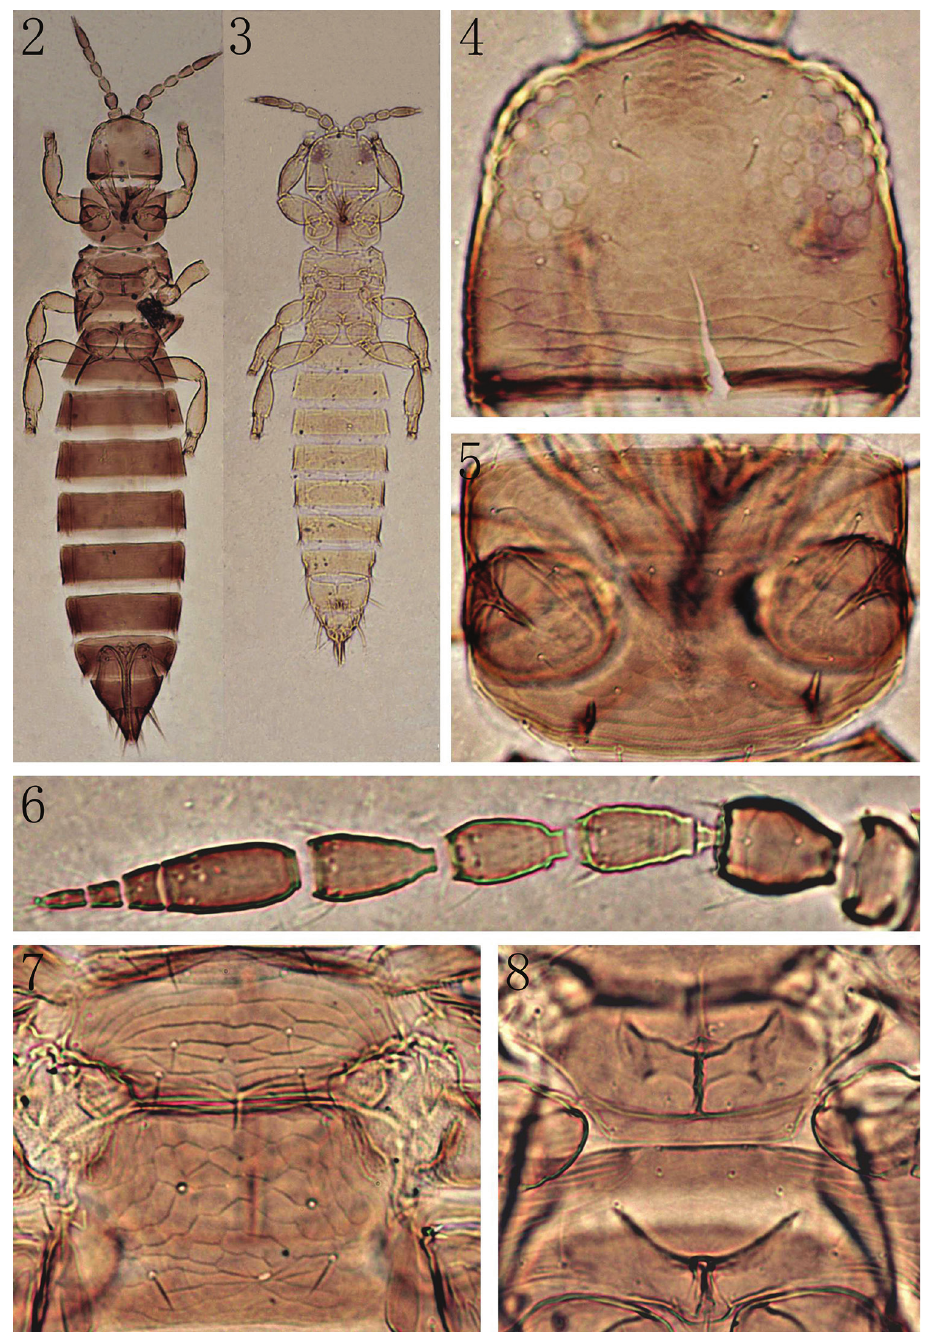
Figures 2–8. Anaphothrips dentatus sp. n. ( 2, 4–8 female 3 male). 2 Female 3 Male 4 Head. 5 Prono- tum. 6 Antenna 7 Meso- and metanotum 8 Meso- and